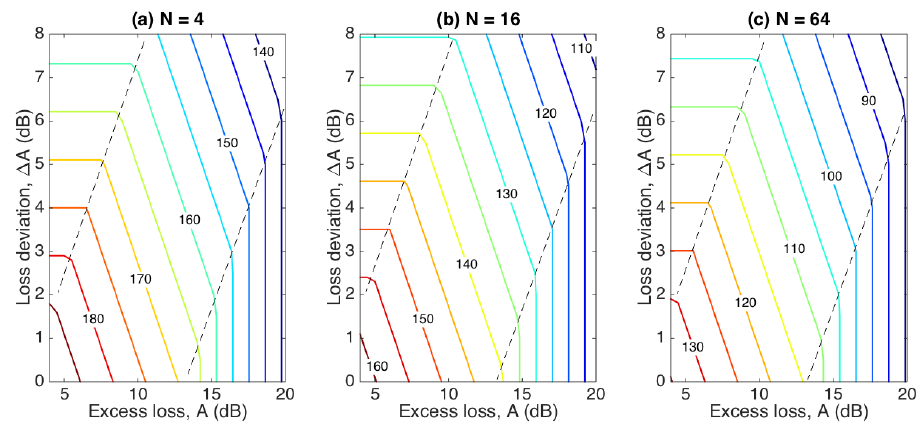
Figure 6. Maximum length S max of the sensing region (text, in centimeters) for the 6th fiber, M01 type, as a function of the impairments parameters A and ∆ A , evaluated for ( a ) 4 channels; ( b ) 16 channels; ( c ) 64